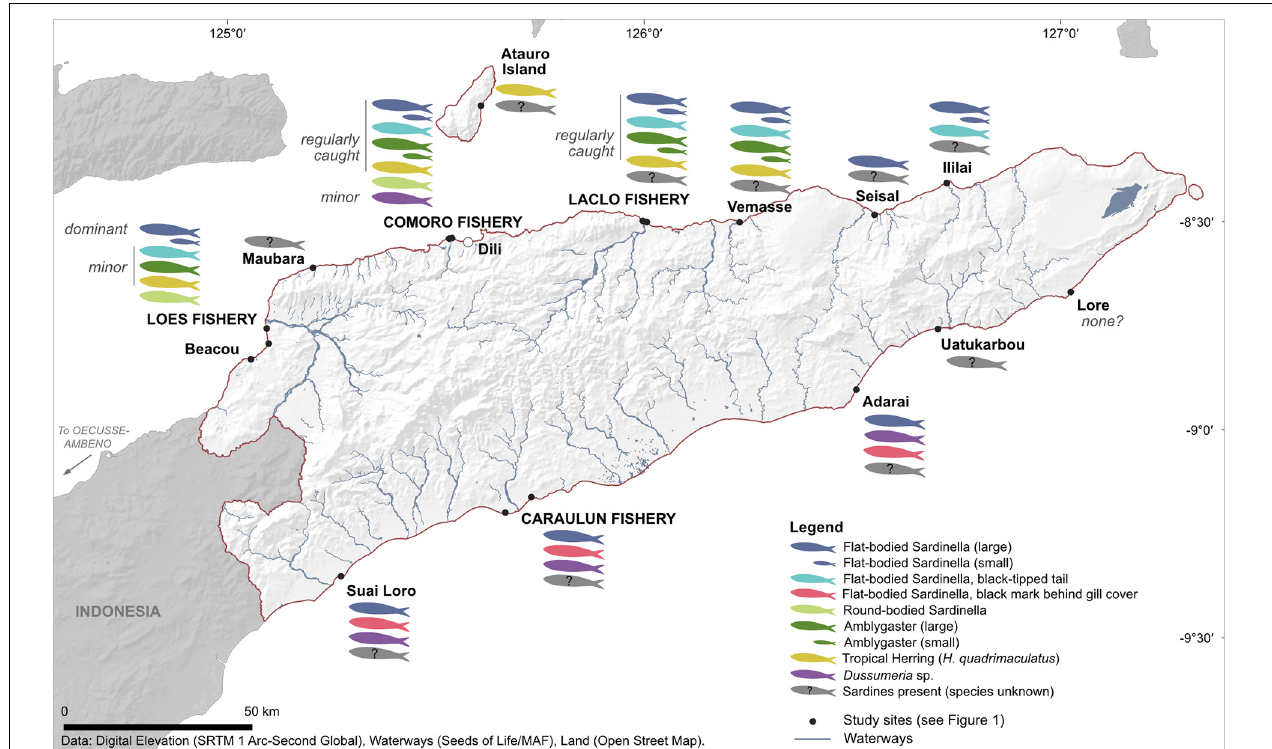
FIGURE 2 | Tropical sardine species reported at fishery locations around Timor-Leste. Data have been grouped for sites where fishers fish at the same location – these fisheries are described by the name of the associated river mouth.